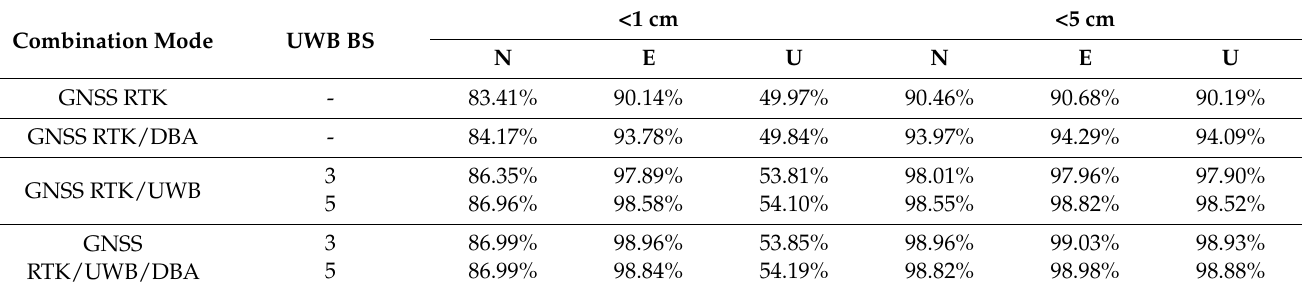
Table 4. Statistics of thee GNSS RTK/UWB/DBA fusion positioning model error distribution intervals in N/E/U directions at a 30 degree elevation mask angle.